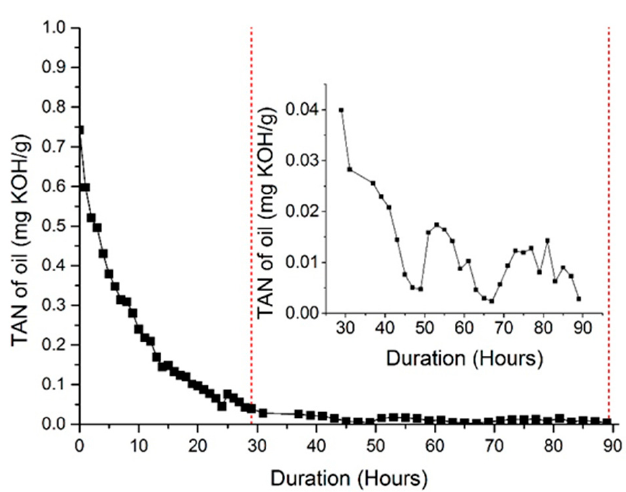
Figure 5. Total acid number (TAN) of oil profile during the regeneration experiment.